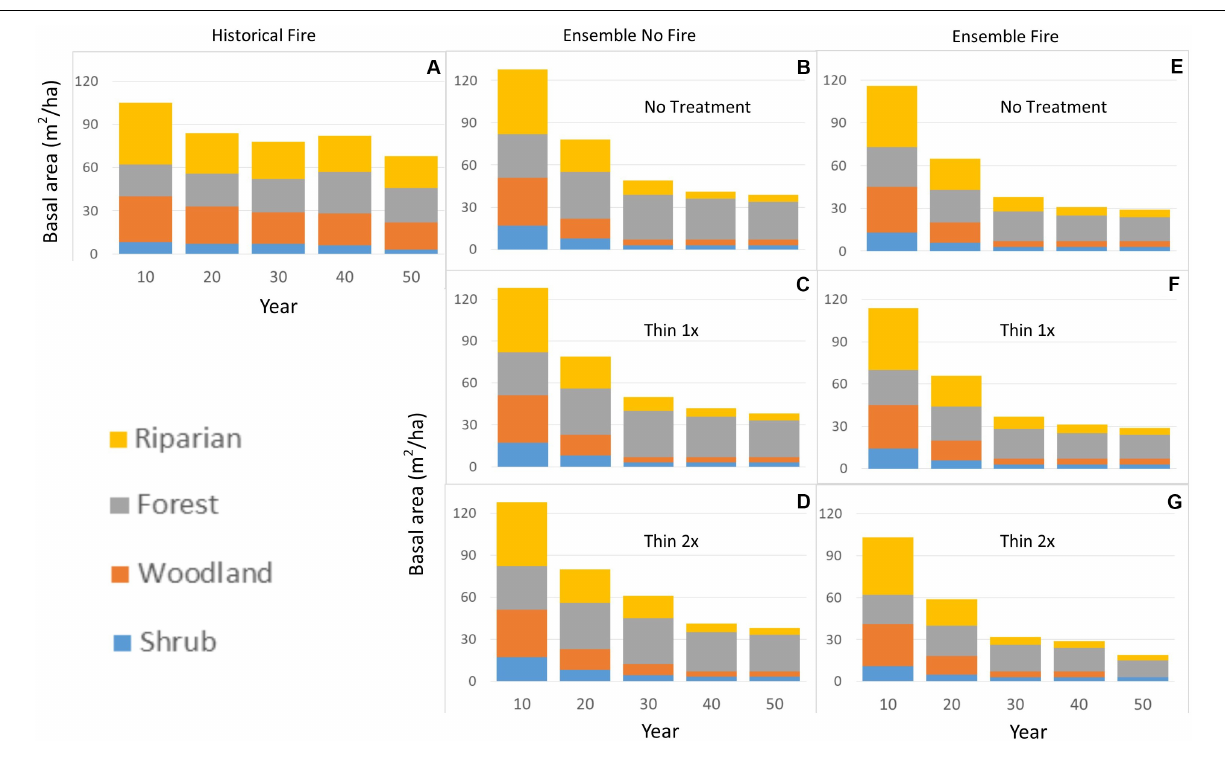
FIGURE 7 | Effects of climate, fire, and fuel treatments on median basal area within vegetation zones. Stacked bar charts summarize changes to shrubland, woodland, forest, and riparian vegetation zones at decadal time steps. Historical climate with fire (A) is used as a baseline for comparison to projected climate ensemble without fire and (B) no fuel treatments, (C) single-entry thinning, and (D) double-entry thinning as well as projected climate with fire and (E) no fuel treatments, (F) single-entry thinning, and (G) double-entry thinning. Basal area values within each vegetation zone are presented in Supplementary Table S1